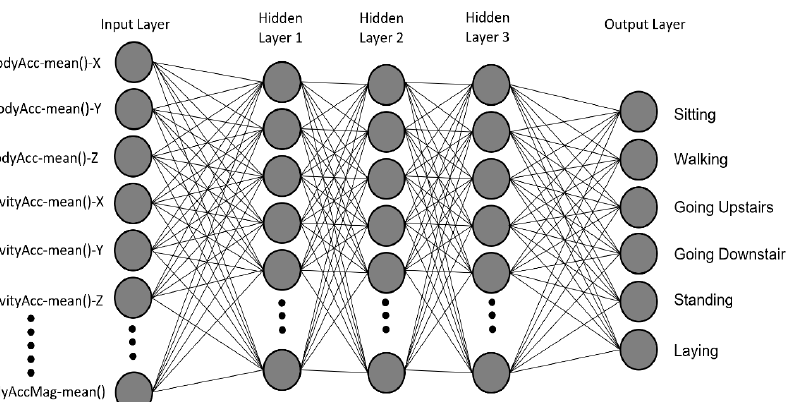
Figure 3. Architecture of the proposed artificial feed-forward neural network with 3 hidden